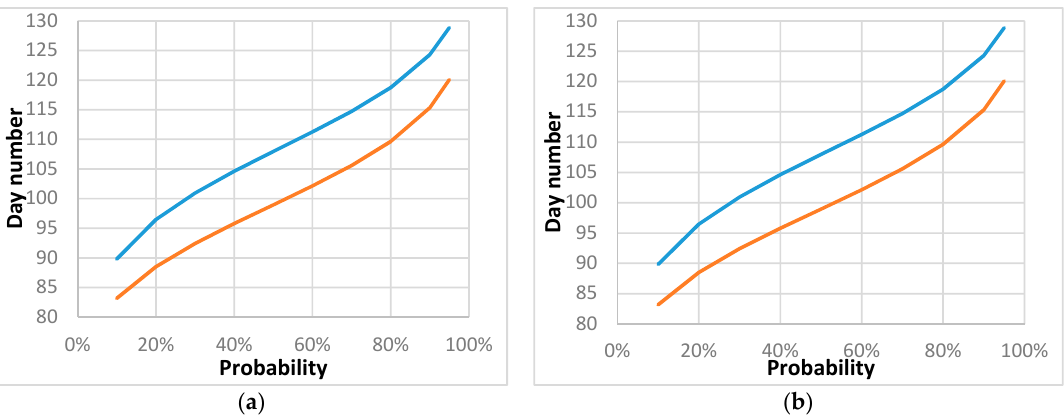
Figure 10. The probability curves of the last spring frost event described by a calendar day number in the period of 1961–1990 (blue line) and 1991–2020 (orange line). ( a ) Wielichowo with Tmin < − 2 °C, ( b ) Lublin Tmin < − 4 °C.